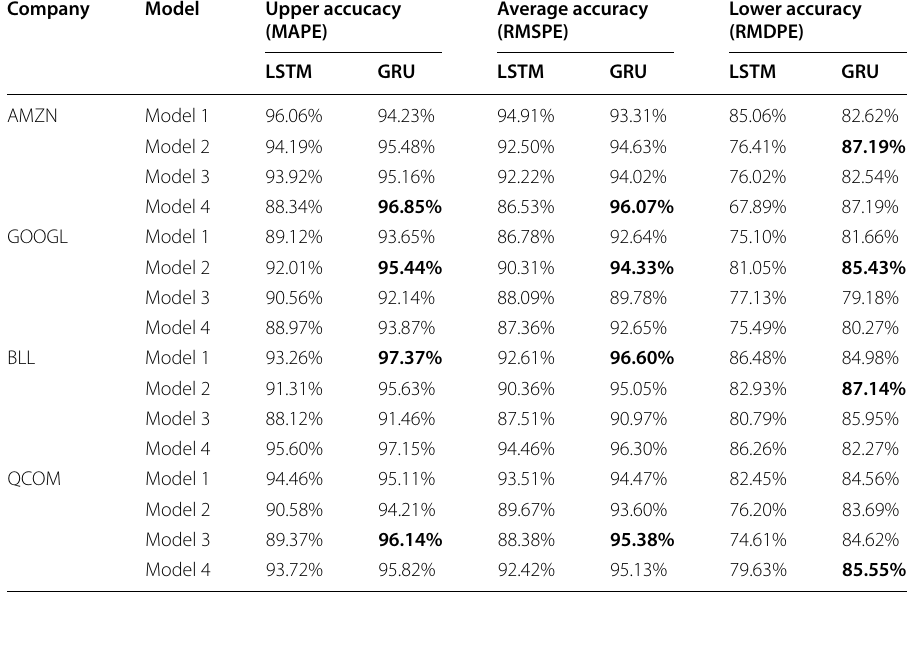
Table 5 Validation accuracy of the LSTM and GRU architectural models Company